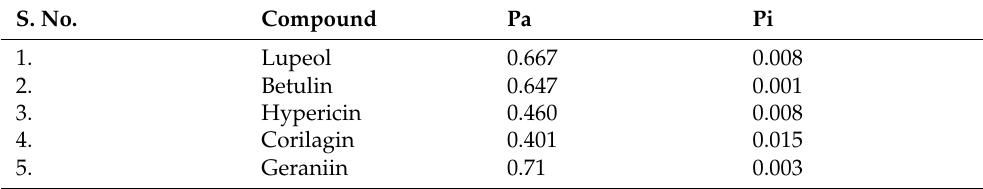
Table 4. PASS scores predicted for the selected phytochemical antiviral inhibitors.